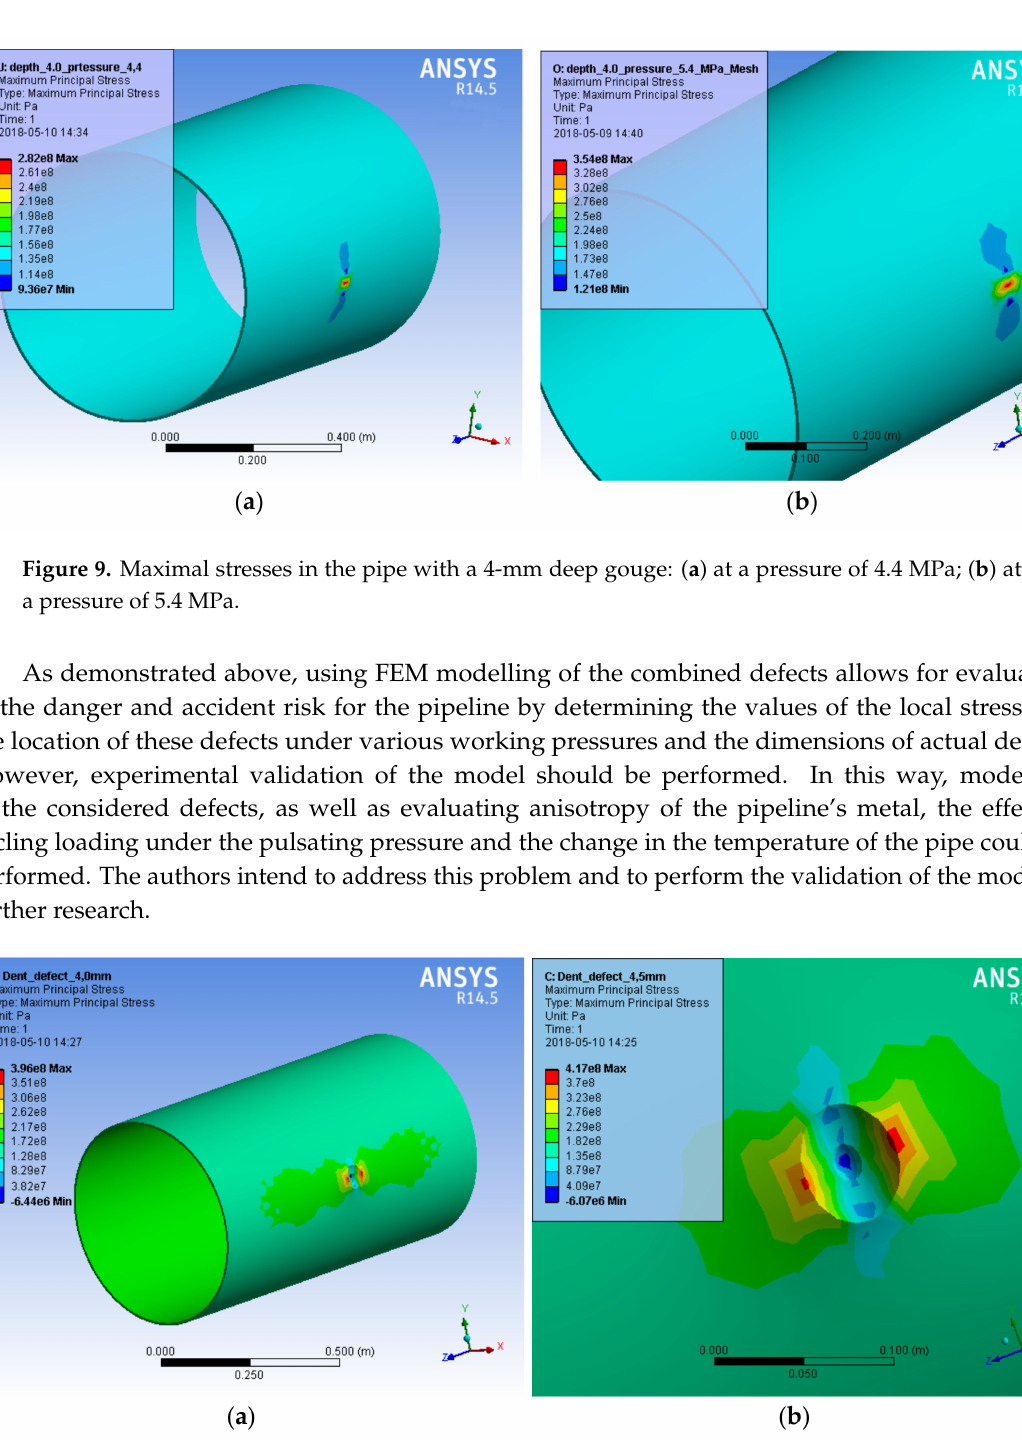
Figure 10. Stresses in the pipe with dent and gouge defects: ( a ) 4.0 mm deep; ( b ) 4.5 mm